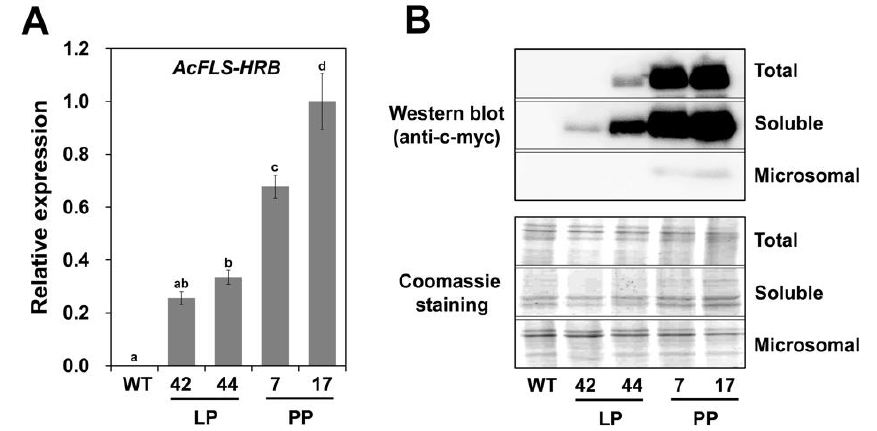
Figure 5. AcFLS-HRB expression and protein contents in WT and AcFLS-HRB- expressing transgenic tobacco petals. ( A ), Relative expression levels of AcFLS-HRB in WT and transgenic tobacco petals, as revealed by qPCR. Error bars indicate ± SD from three replicates. Statistical significance was determined by one-way ANOVA with post-hoc Tukey’s tests. Significant di ff erences between means ( p < 0.05) are indicated by lower-case letters (a, b, c, and d) above the bars. ( B ), Immuno blot analysis of WT and transgenic petals using anti-c-myc antibody. Coomassie staining was conducted for the loading control. LP, light pink transgenic lines; PP, pale pink transgenic